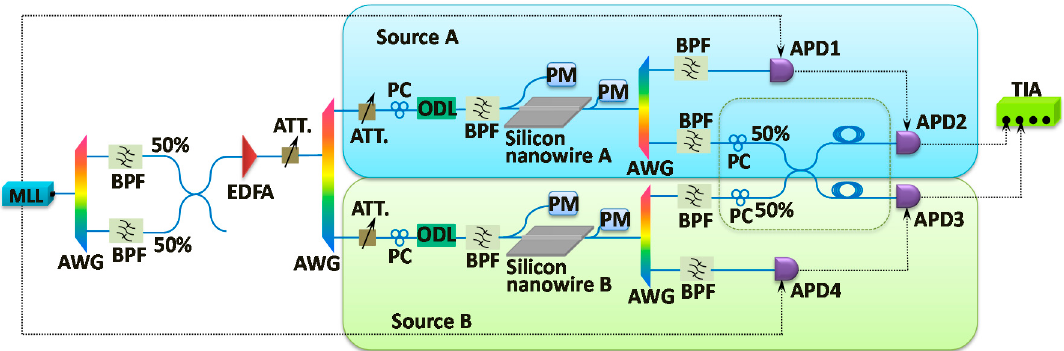
Figure 2. Experimental setup. The polarization controller (PC), 50:50 coupler, and additional fiber before avalanche photon diode APD2 and APD3 are only for the Hong–Ou–Mandel (HOM) quantum interference, and are removed for initial characterization of the sources. ATT is a tunable attenuator; BPF: band pass filter; EDFA: Erbium-doped fiber amplifier; MLL: mode locked laser; ODL: optical delay line; PM: power meter; TIA: time interval analyzer.